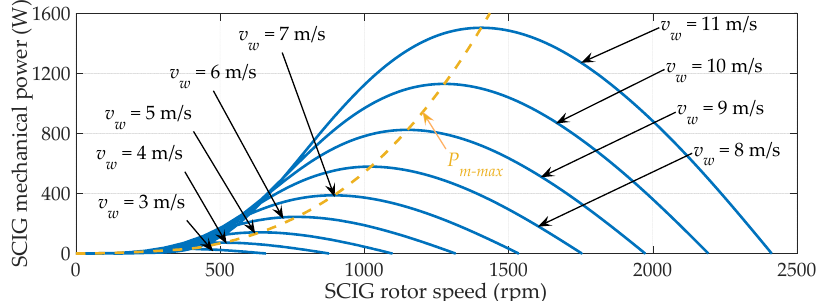
0 Figure 3. Mechanical power vs. rotor speed characteristics of the WT-driven SCIG. The WT MPPT algorithm utilizes the SCIG mechanical power ( P m ) as the input variable and generates the rotor speed reference ( ω * r ) at the output (i.e., S 2 in Figure 2 is in position 1). The corresponding block diagram including the FL controller (FLC) is shown in Figure 4. The reference speed is adjusted by Δω * r on the basis of the change in the P m and Δω * r sign from the previous step. Due to the relatively large WT inertia, the reference speed is adjusted every 3 s, thus allowing the WT speed to stabilize between successive adjustments in order to correctly interpret the WT power trend. (pu) ω * r Δ Figure 4. Block diagram of the fuzzy logic (FL)-based WT MPPT algorithm. Once the P m change ( Δ P m ) recorded between two successive steps falls within ±1 W, the WT MPPT algorithm is put on hold and the SCIG MPPT algorithm takes over (i.e., S 1 in Figure 2 is moved to position 2). The input and output scaling factors, K in _ ω = 0.014 and K out _ ω = 20, in Figure 4 serve to reduce the related variables to the range [ − 1, 1]. Their values were derived by trial and error from simulation studies. The rule base for the FLC in Figure 4 is presented in Table 1. N, P, and Z stand for negative, positive, and zero, respectively, whereas S, M, and B stand for small, medium, and big, respectively. Note that the total number of rules is 14, which proved to be the minimum number of rules ensuring stable operation and fast convergence of the WT MPPT algorithm.